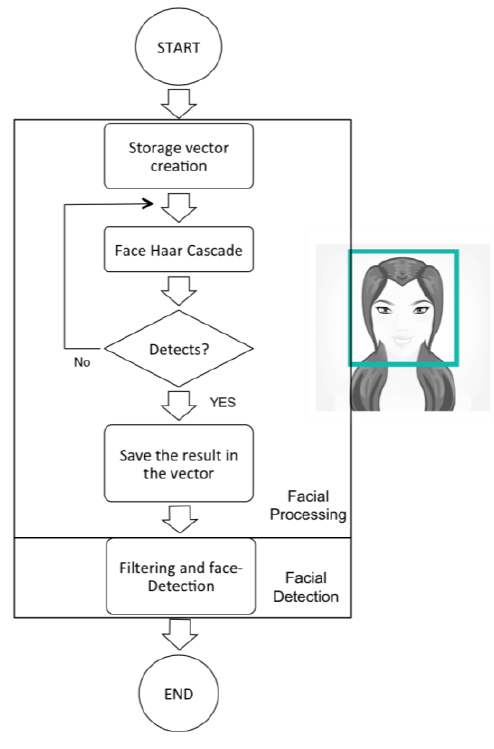
Figure 6. Low-level diagram of second stage.